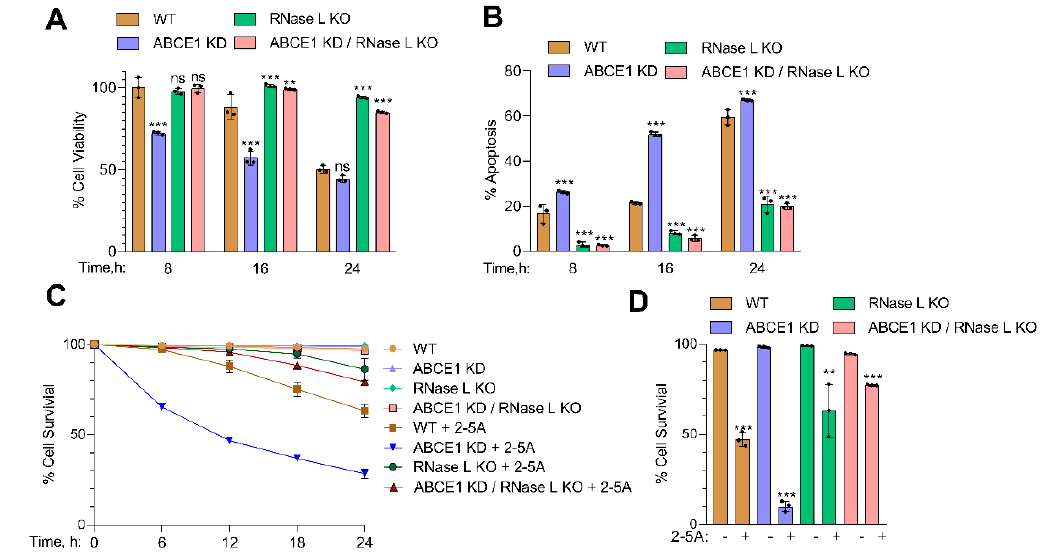
Figure 3. Involvement of ABCE1 in RNase L-induced apoptosis in response to 2-5A treatment. HT1080 WT, ABCE1 KD, RNase L KO, and ABCE1 KD/RNase L KO cells were transfected with 10 μ M of 2-5A for indicated times and ( A ) cell viability was measured using MTS reagent. ( B ) The percent of apoptotic cells was determined by trypan blue dye exclusion assay. Results are representative of three independent experiments performed in triplicate and shown as mean ± SD and compared to WT cells; and ( C ) real-time cell viability was measured over time using a dual dye monitoring system in cells transfected with 2-5A and compared to mock-transfected cells. The percent cell survival in each well was determined by quantitating dead cells and normalized to the total number of cells at each time point. Data are representative of four values per well performed in triplicate from three experimental samples and shown as mean ± SD. ( D ) Quantitation of percent cell survival at 30 h after 2-5A transfection normalized to mock-transfected cells. WT: wild-type; ** p < 0.01; *** p < 0.001; ns: not significant.